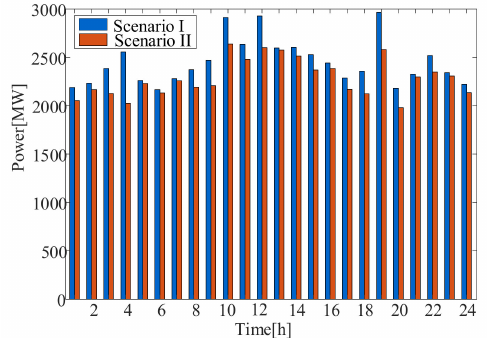
Figure 12. Results of coordinated optimal dispatch of thermal power units (TPUs).